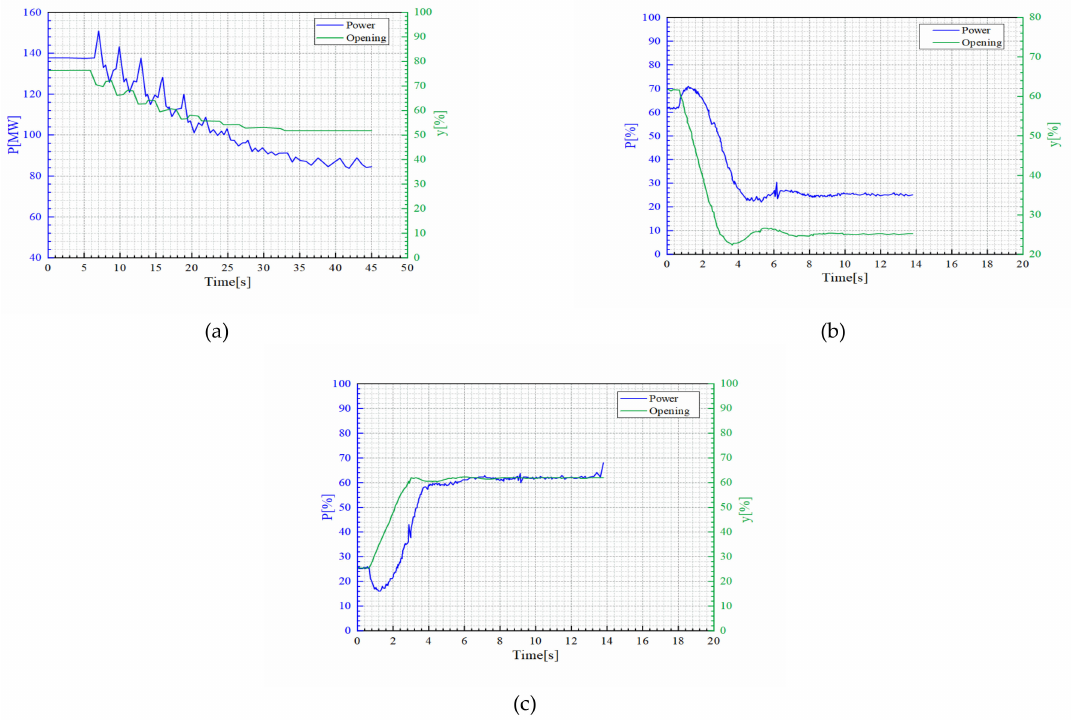
Figure 4. Instability of hydropower unit power regulation. ( a ) Power oscillation; ( b ) Reverse power regulation; ( c ) Reverse power